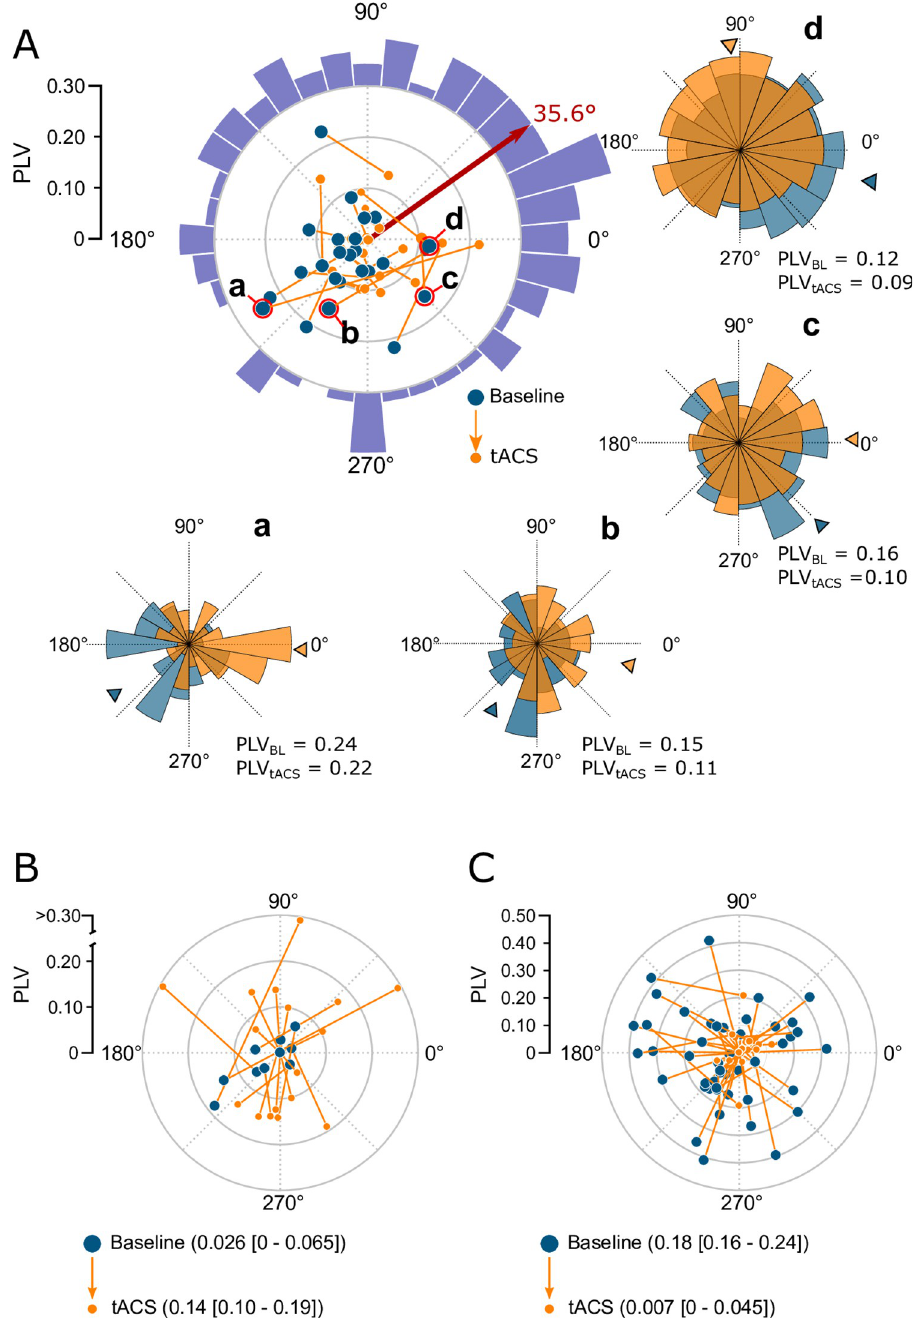
Fig 2. Ongoing oscillations determine the strength and phase of tACS entrainment. These polar plots summarize the combined effects of tACS on entrainment strength (PLV, eccentric direction) and entrainment phase (polar angle). Each vector begins during baseline (blue dot) and extends to 1 mA tACS condition (gray dot). (A) Individual vectors for the 22 neurons that had no significant change in PLV but a significant phase preference during baseline. The red arrow indicates their average direction of change. Spike phase histograms are shown for the 4 example cells circled in red. The violet histogram shows similar changes in direction across the entire population of 93 neurons whose PLVs were not significantly affected by tACS. It also peaks at 38˚, near the red arrow tip. (B, C) Neurons showing individually significant increases (B) and decreases (C) in PLV, plotted in the same style. No red arrows are included in these panels because the population has no net phase preference ( p > 0.05; Hodges–Ajne omnibus test), in part because neurons had weak phase preferences in either the baseline condition (B) or tACS condition (C), as